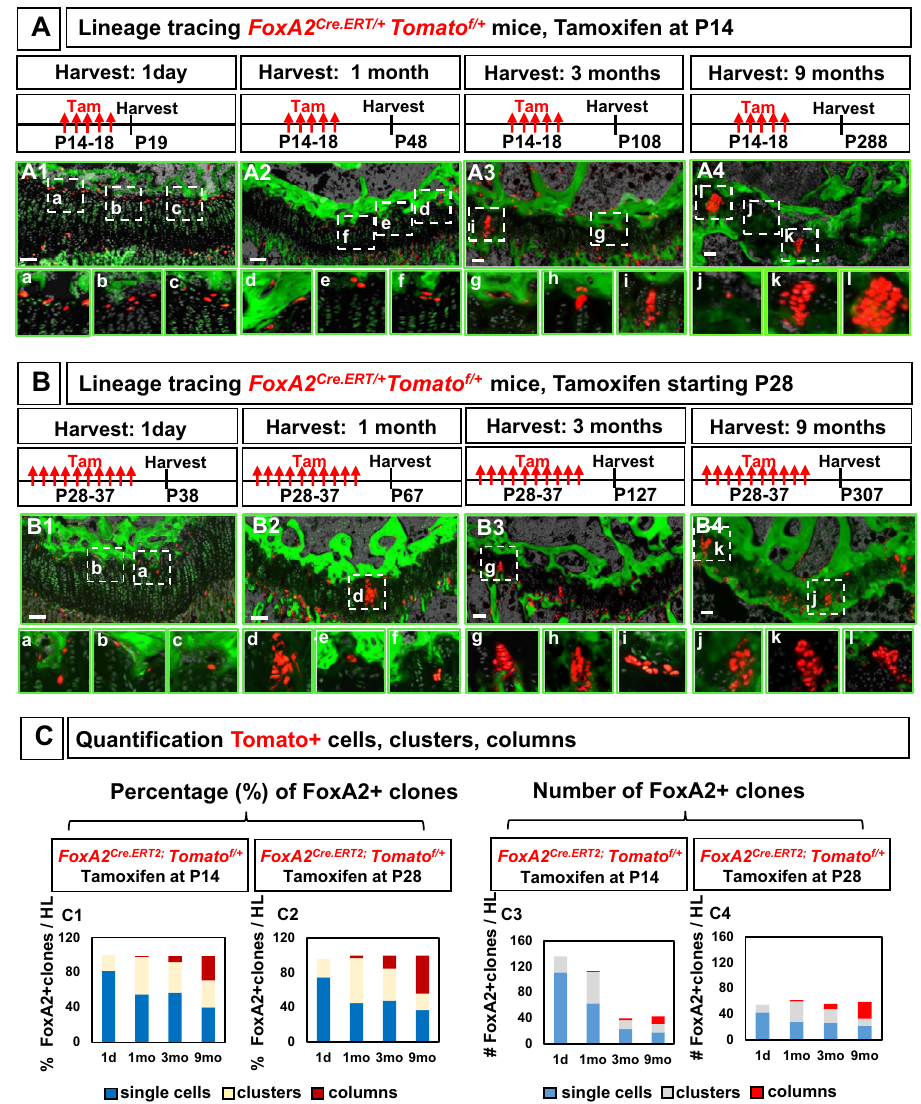
Fig. 4 Dual osteo-chondro-potential for FoxA2 + cells in the early weeks of postnatal development (P14) and stronger chondrogenic potential beyond P28. A Tibia sections harvested from FoxA2 CreERT2/ + ;Tomato fl / + mice treated with 5x tamoxifen (Tam) injections starting at P14, and harvested at 1 day ( A1 ), 1 month ( A2 ), 3 months ( A3 ), and 9 months ( A4 ) after the last injection. Hoechst (gray), 5-DTAF (green). Bars, 100 µ m. Representative details from GP sections, in numbered insets ( a – l ). B Tibia sections harvested from FoxA2 CreERT2/ + ;Tomato fl / + mice treated with 10x tamoxifen injections starting at P28, and harvested at 1 day ( B1 ), 1 month ( B2 ), 3 months ( B3 ), and 9 months ( B4 ) after the last injection. Hoechst (gray), 5-DTAF (green). Bars, 100 µ m. Representative details from GP sections, in numbered insets ( a – l ). C Quanti fi cation of the number ( C3 , C4 ) and the percentage ( C1 , C2 ) of single cells, clusters, columns formed at 1 day, and 1, 3, 9 months after the last injection. Percentage (%) single cells is calculated by the number of single Tomato + cells in the GP (outside the green 5-DTAF domain) to the total number of Tomato + units (single cells, clusters and columns). Each point represents the sum of n = 8 sections per mouse hindlimb. Similar quanti fi cation of percentage (%) clusters and columns. One Tomato + unit, is de fi ned by 1 single cell, or 1 cluster comprised of two or more cells grouped together, or by 1 column of